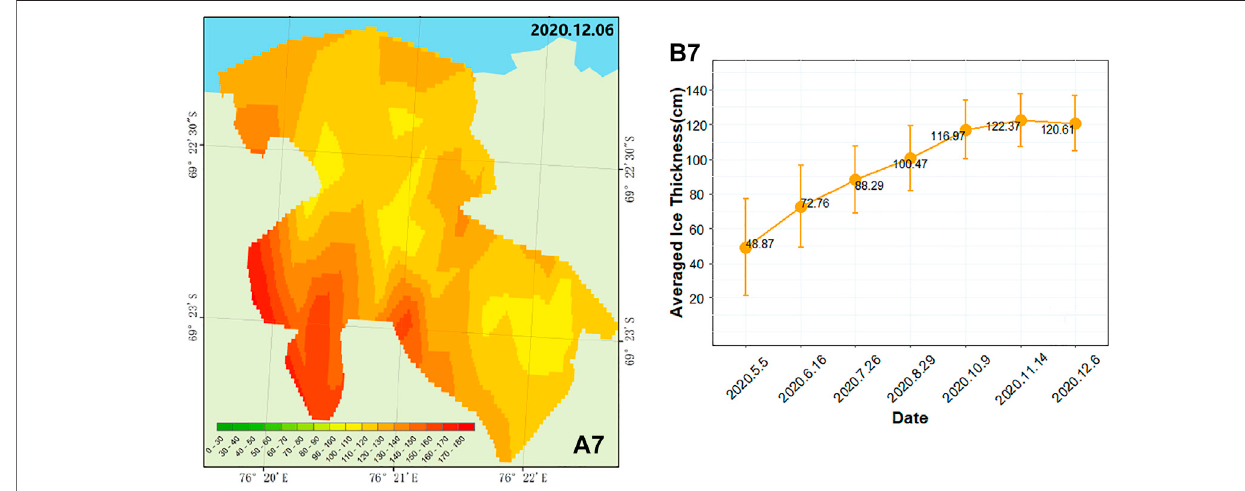
FIGURE 4 | Relationship between snow thickness and sea ice growth rate. (Red solid line: snow thickness on May 5, June 16, July 26, August 29, October 9 and November 14; black dotted line: sea ice thickness growth rate from May 5 to June 16, from June 16 to July 26, from July 26 to August 29, from August 29 to October 9, from October 9 to November 14 and from November 14 to December